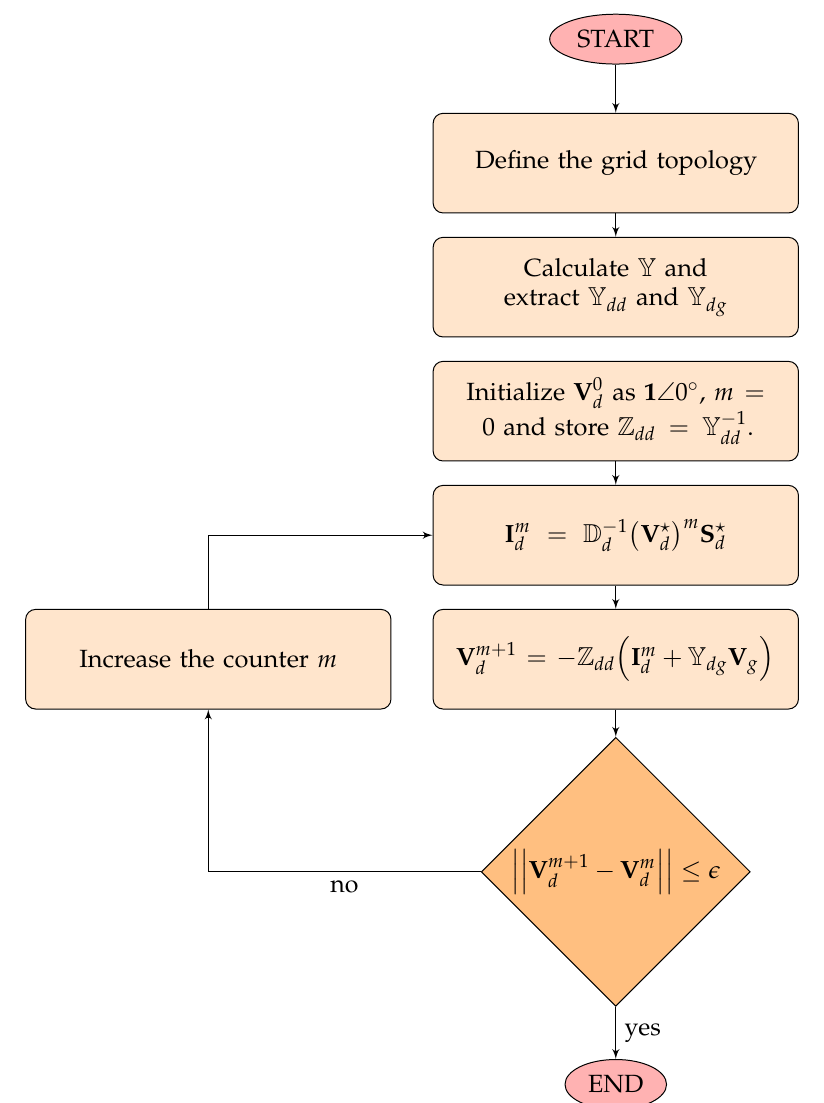
Figure 1. Flowchart of the proposed power flow method based on successive approximations.